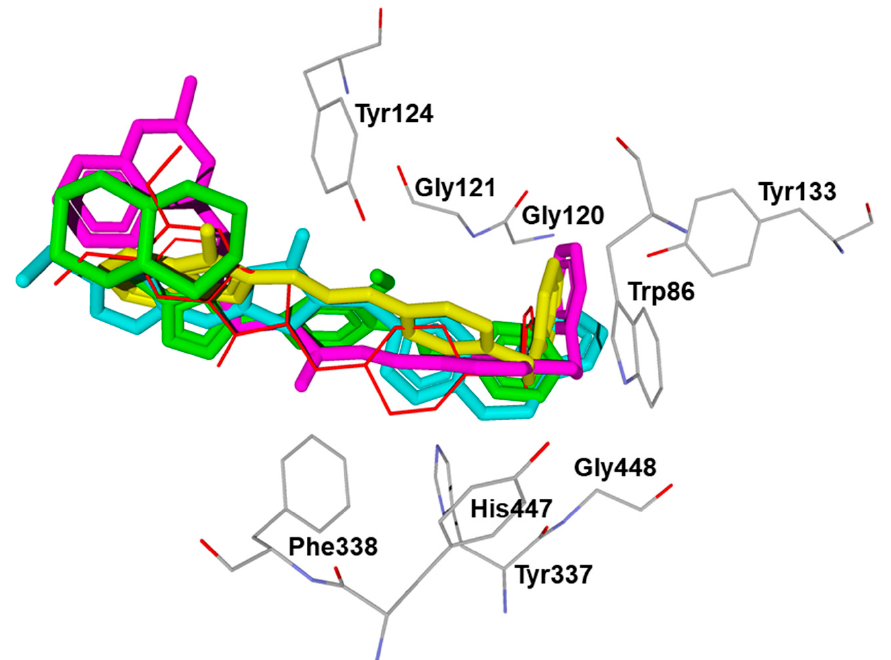
Figure 3. Superimposed docking poses of compounds 15 (green), A (yellow), B (light blue), and C (magenta) in AChE (PDB code 4EY7). The co-crystallized ligand donepezil is shown in thin red sticks. The residues embracing the hydrophobic pocket of AChE are visible. The positions of the co-crystallized donepezil and AChE residues correspond to their “native” location in the 4EY7 structure.